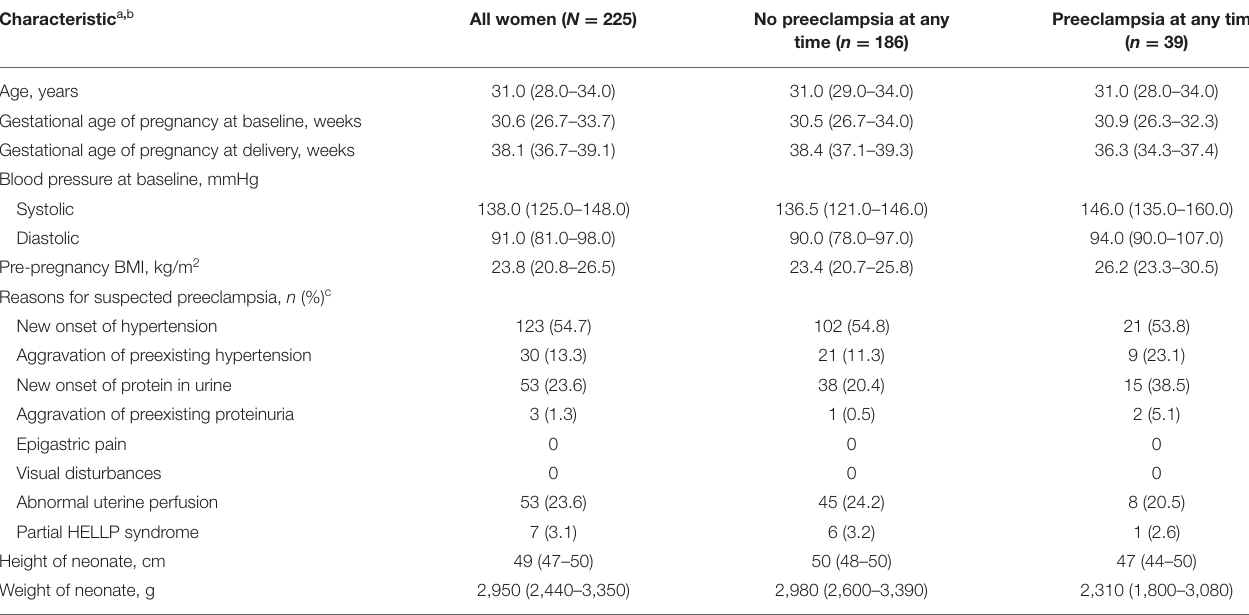
TABLE 1 | Participant demographics and characteristics at baseline for the whole cohort and according to preeclampsia status. Characteristic a , b All women ( N =